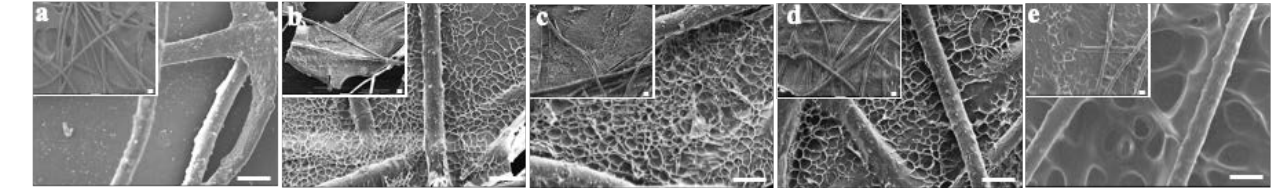
Figure 1. FESEM characterization of gelatin@NWF scaffold prepared at different conditions. ( a ) NWF, ( b ) 6% gelatin@NWF, ( c ) 9% gelatin@NWF, ( d ) 12% gelatin@NWF, ( e ) 9% gelatin@NWF ( − 80 °C), scale bar = 50 µm.